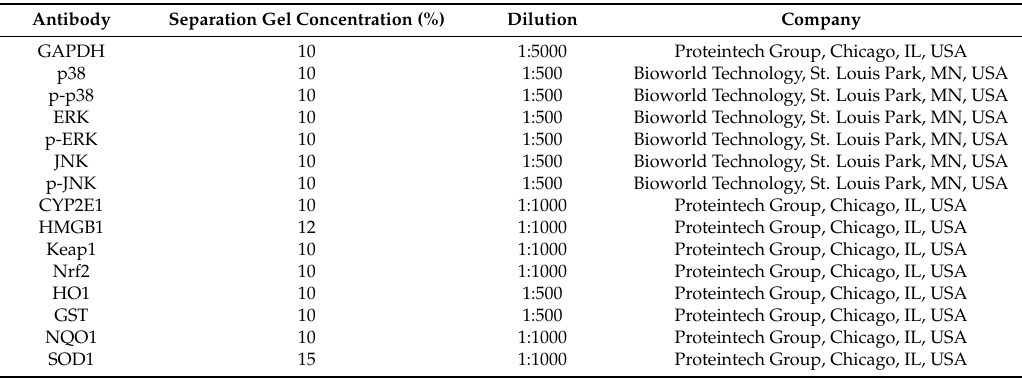
Table 2. The information of the antibodies used in the present